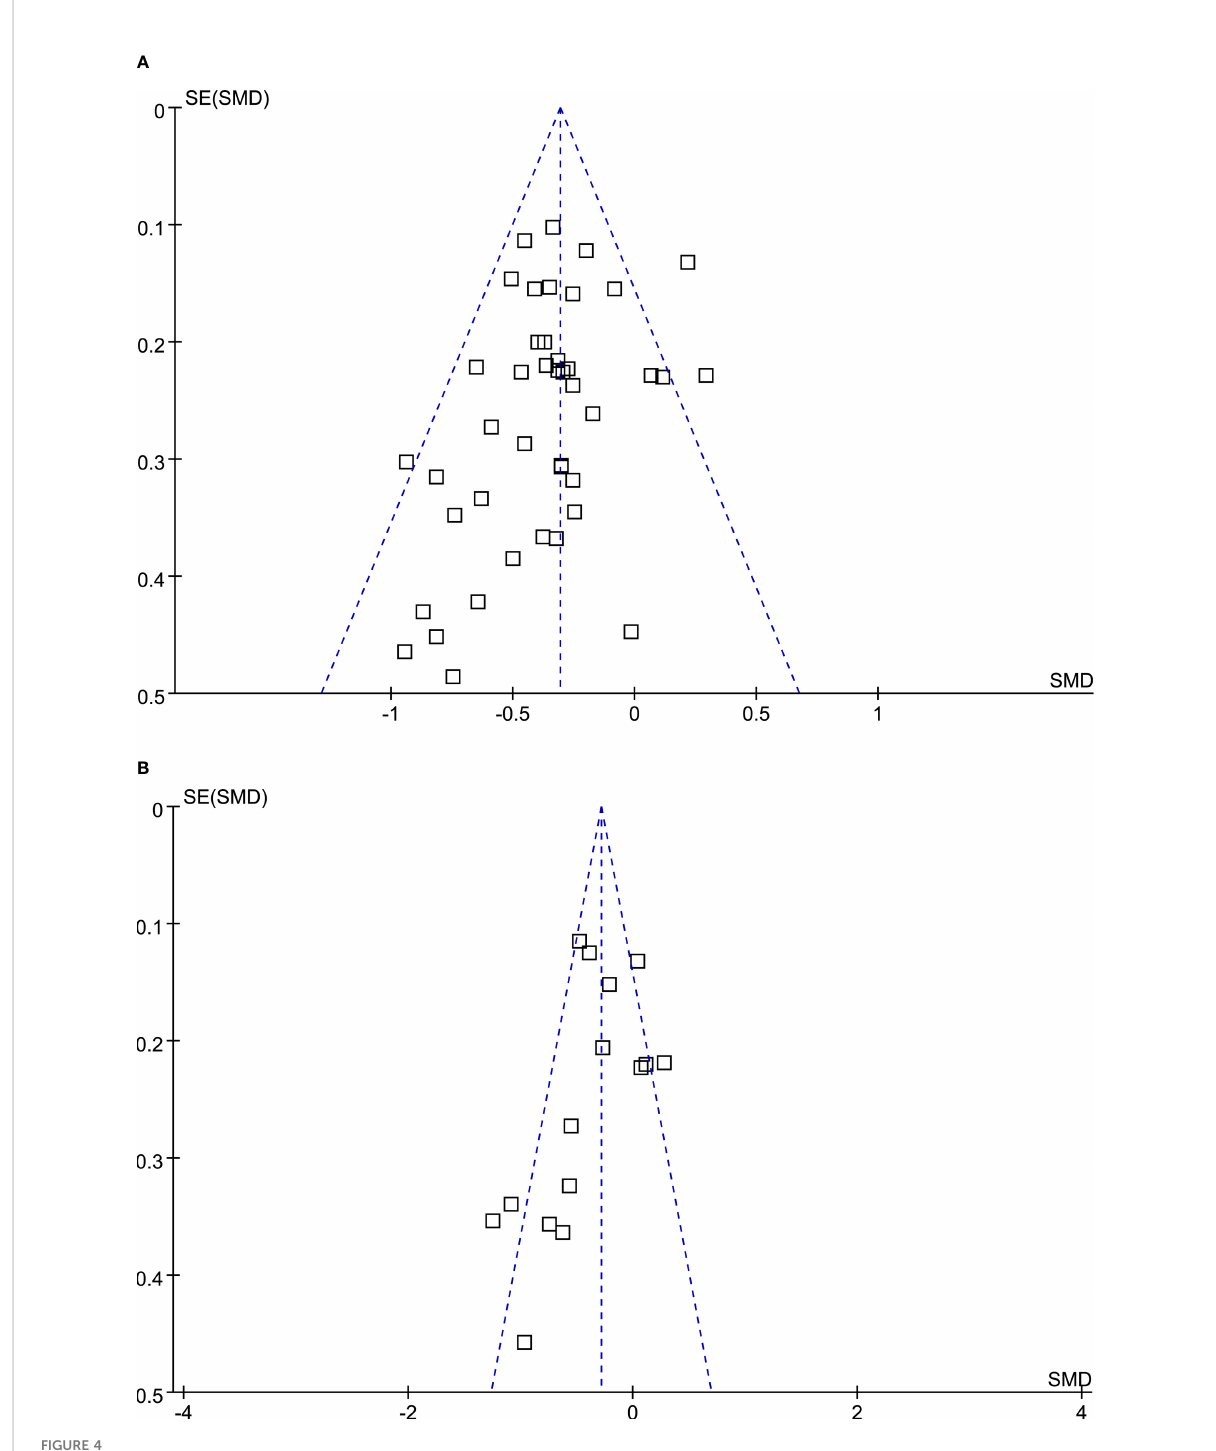
FIGURE 4 Funnel plots for the meta-analysis evaluating the in fl uences of DPP4 inhibitors on circulating glucagon in T2DM patients. (A) Funnel plots for the meta-analysis comparing the effects of DPP4 inhibitors and placebo; and (B) funnel plots for the meta-analysis comparing the effects of DPP4 inhibitors and other